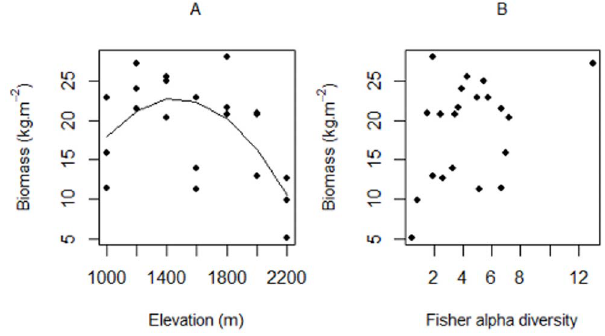
Figure 5. Relationships between above ground biomass and (A) elevation (y=18.81-11.35x-14.32 x 2 , R 2 =0.35, all stations 2200 m included), and (B) diversity (fisher’s alpha) of subcanopy and canopy vegetation combined on Mount Rinjani, Indonesia. Solid lines indicate relationships including all elevation stations and the dashed lines indicate relationships when the station at 2200 m (fire-maintained grassland) was omitted. Only significant ( p , 0.05) relationships are